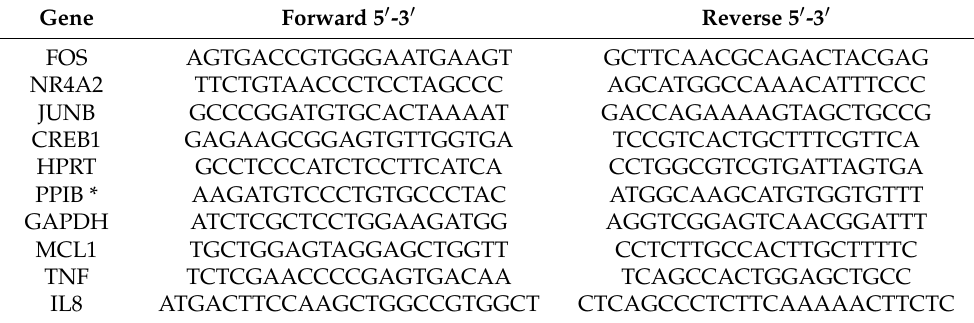
Table 1. Primer pairs used for